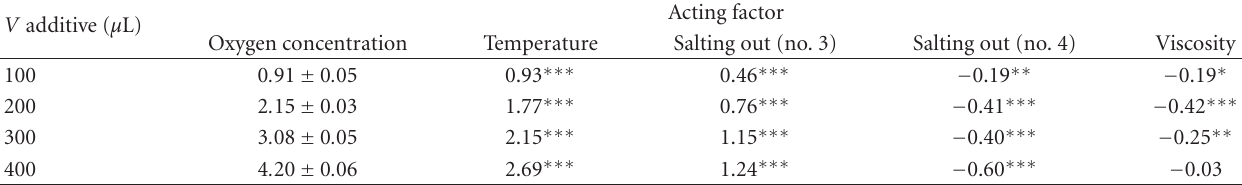
Table 4: Individual contributions of separate factors to the total value of false oxygen consumption Δ N (mol × 10 − 8 ), n = 10. V additive ( µ